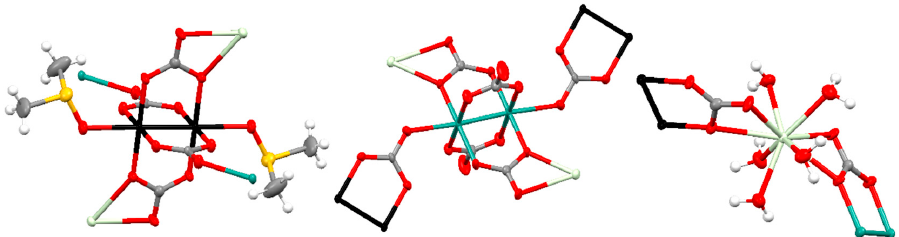
Figure 6. Representation (50% probability ellipsoids) of the coordination environments of the Ru 25+ ( left and center ) and Gd 3+ ( right ) units that form the structure of Gd β . Ruthenium: turquoise and black; gadolinium: pale green; oxygen: red; carbon: gray; sulfur: yellow; hydrogen: white. Ellipsoids of the hydrogen atoms are omitted for clarity.